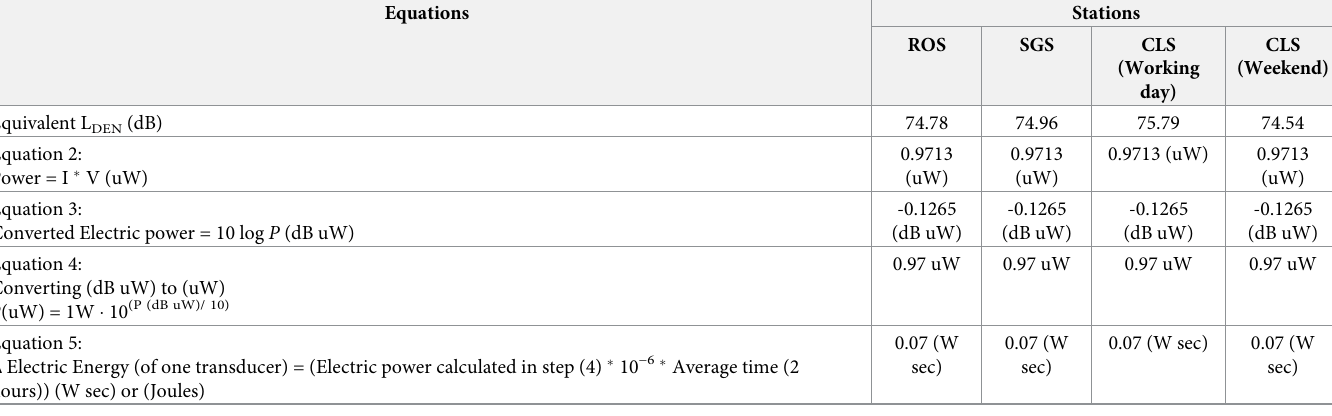
Table 14. The conversion process of noise to electric energy produced by one piezoelectric transducer of QB220-503YB at the selected stations through the data sheet presented in Table 4 and equations 2, 3, 4 and 5. Equations